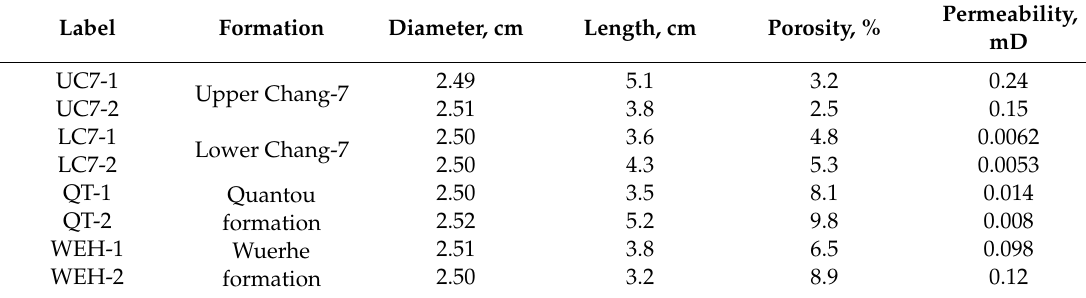
Table 1. The physical properties of tight reservoirs samples.